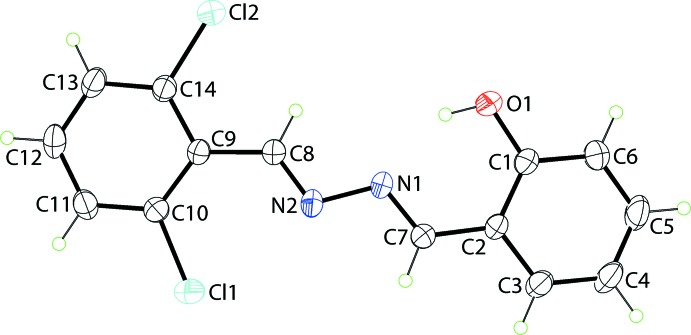
The mol­ecular structure of (I) showing the atom-labelling scheme and displacement ellipsoids at the 35% probability level.